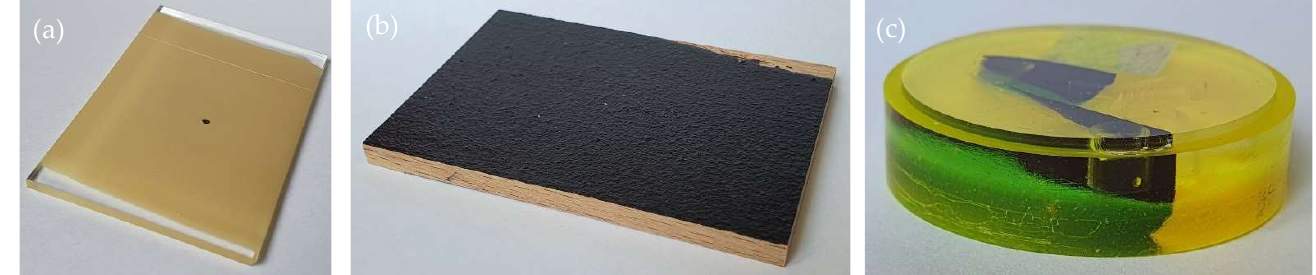
Figure 1. Prepared samples for the nanoindentation: ( a ) the adhesive film on glass, ( b ) on wood, ( c ) embedded in epoxy resin.